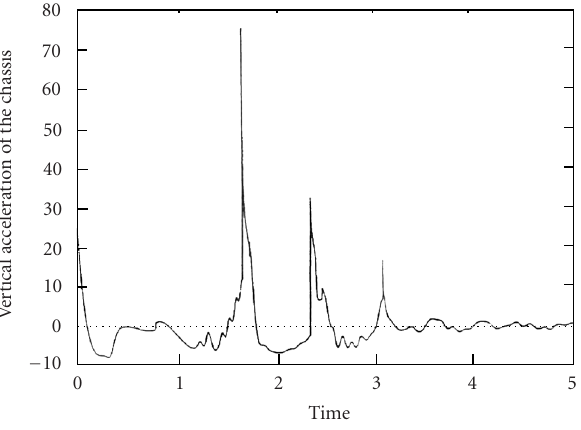
Figure 2.6. The time variation of the vertical acceleration of the chassis (m/s 2